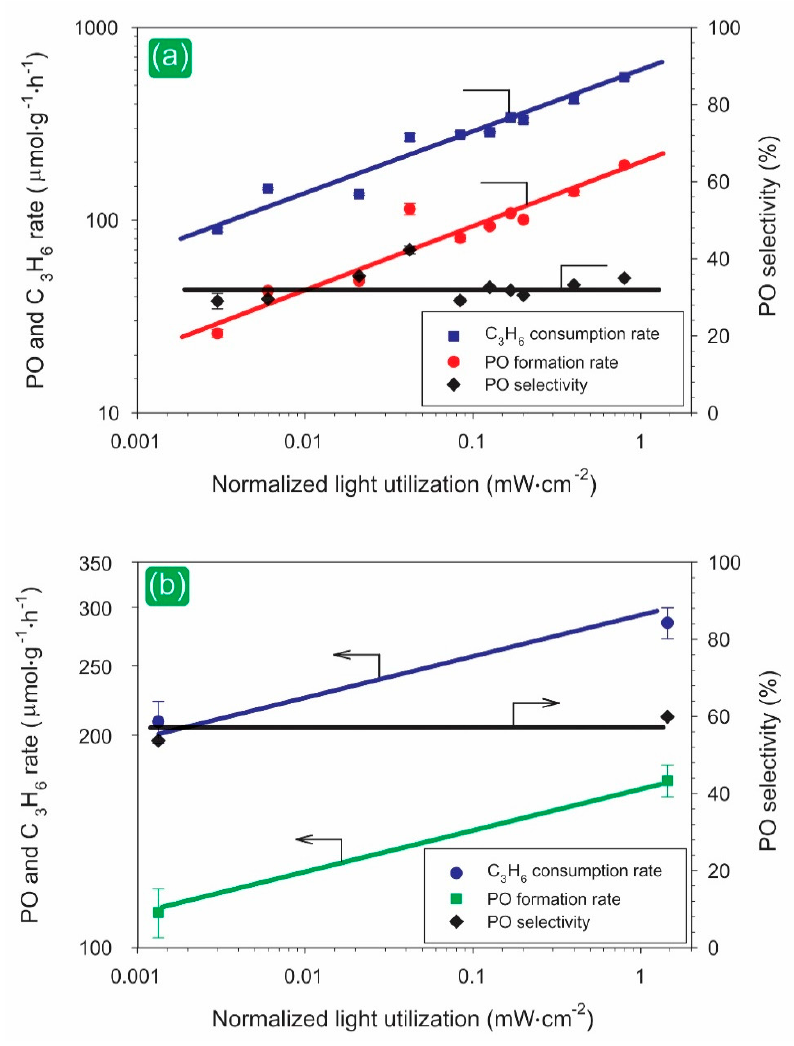
Figure 5. The correlation of catalytic activities versus normalized light utilization (NLU) over V-Ti / MCM-41: ( a ) a Hg Arc lamp and ( b ) a Xe lamp. Reproduced with permission from [19] .